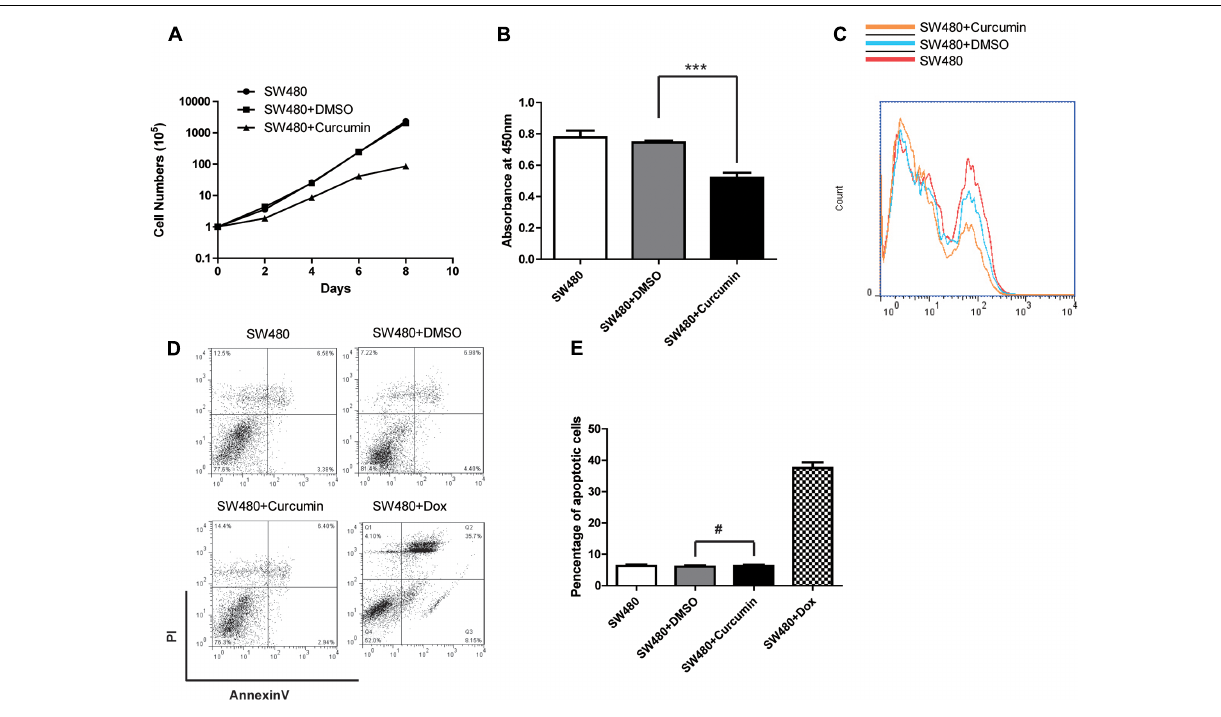
FIGURE 2 | Curcumin inhibited the cell proliferation of SW480. (A) Cell proliferation of different groups as indicated was determined by cell counting. The concentration of curcumin was 40 µ M. Data were represented as mean ± SD; n = 3 independent experiments. (B) CCK-8 kit was used to evaluate the viability of each group of the cells as indicated. Data were represented as mean ± SD; n = 3 independent experiments. ∗∗∗ p < 0.001. (C) Cell proliferation was detected by BrdU incorporation assay and n = 3 independent experiments and this panel presented one of these repeats. (D) The apoptosis of the SW480 cells with different treatment as indicated was determined by using the Annexin-V-FITC & PI Apoptosis Kit and assessed by flow cytometry. n = 3 independent experiments and this panel presented one of these repeats. (E) Statistic of percentage of the apoptosis cells performed in (D) . Data showed the Annexin-V and PI double positive cells. Data were represented as mean ± SD; n = 3 independent experiments. # p >